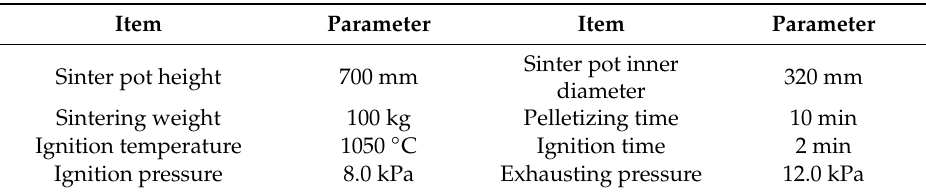
Table 5. Parameters of HCVTM sintering pot